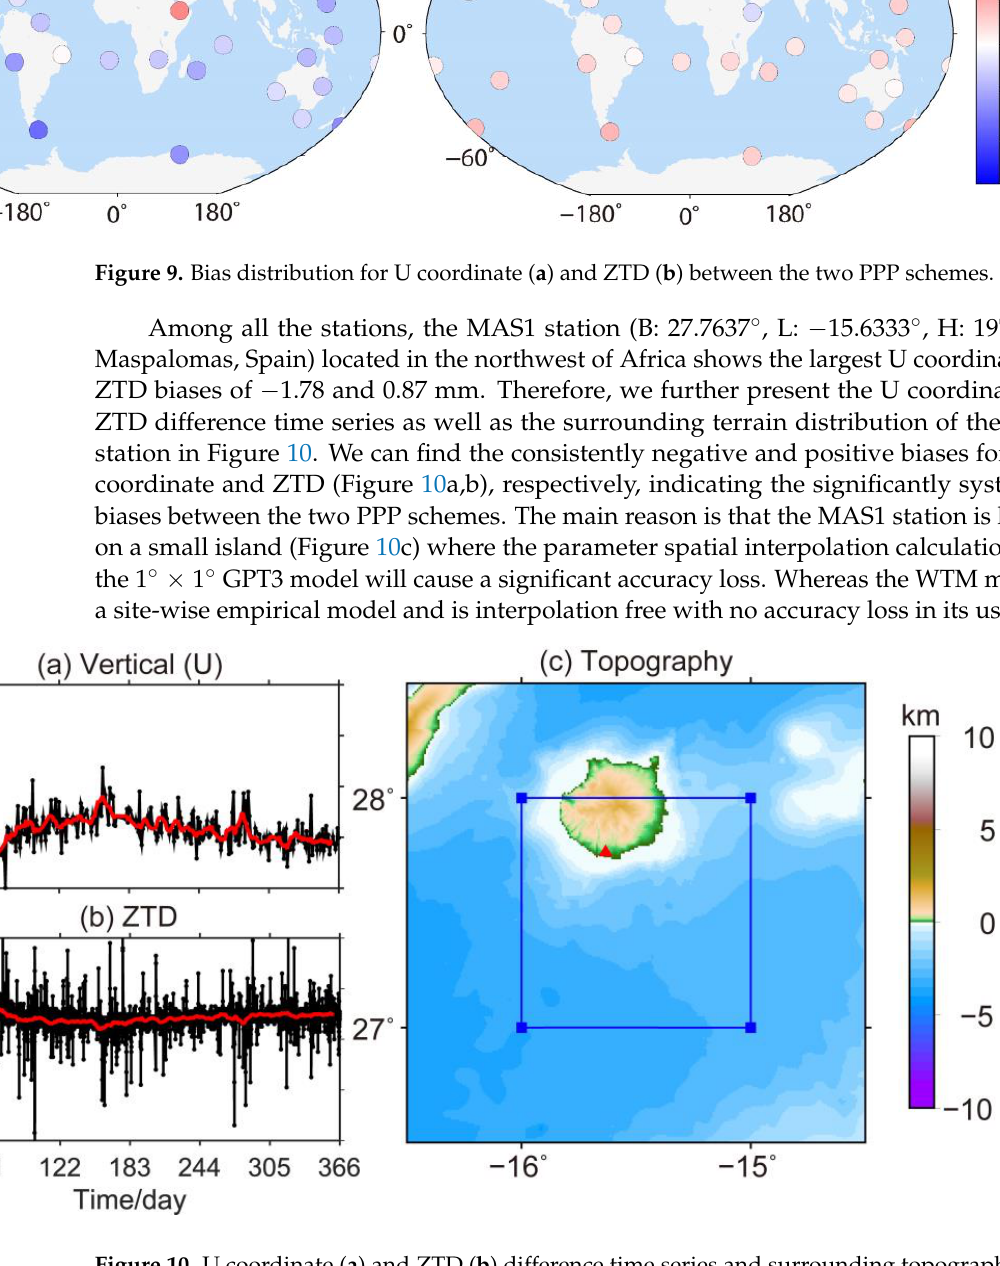
Figure 10. U coordinate ( a ) and ZTD ( b ) difference time series and surrounding topography ( c ) of the MAS1 station. The black lines represent the original time series. The red lines denote the weekly smoothed time series. The red triangle shows the station location. The blue grid stands for the 1 ◦ × 1 ◦